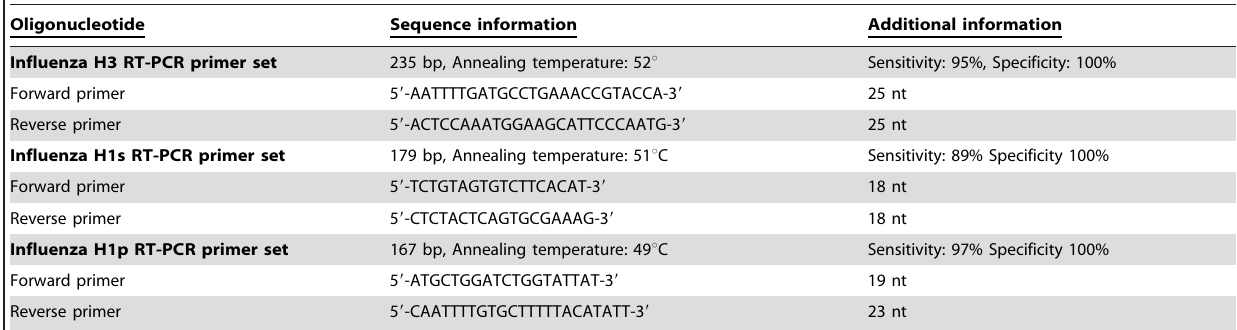
Table 1. Primer sets and sensitivities for each